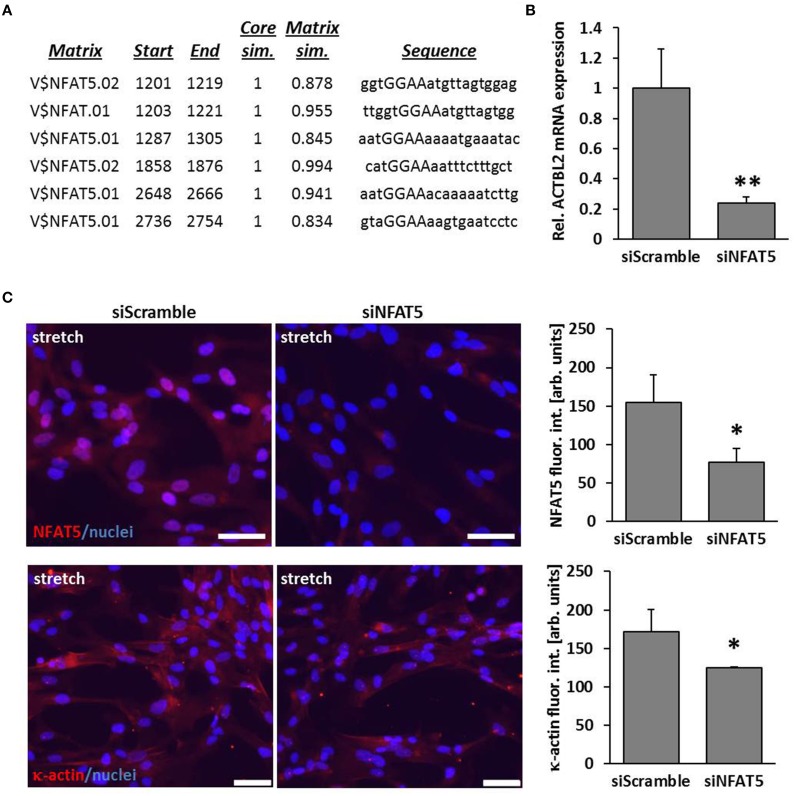
ACTBL2 is a transcriptional target of NFAT5. In silico promoter analysis of the human ACTBL2 promoter revealed six putative NFAT5 binding sites (A). The first 3203 bp of the promoter sequence upstream of the transcription start site were analyzed. The maximum core similarity (Core sim.) of 1.0 is only reached when the highest conserved bases of a matrix are exactly matched by the sequence (cf. capitals in the sequence). A good match to the matrix has a similarity of >0.80 (Matrix sim.). Quantitative PCR (qPCR) of stretch-stimulated HUASMCs treated with NFAT5-specific siRNA (siNFAT5) showed a significant decrease in ACTBL2 mRNA expression compared to stretch-stimulated control siRNA(siScramble)-transfected cells (B, **p < 0.01 vs. control siRNA, n = 3 scale bar: 20 μm). SiRNA-mediated knockdown of NFAT5 (C, *p < 0.05 vs. siScramble) decreased κ-actin (C, *p < 0.05 vs. siScramble) in stretch-stimulated VSMCs as evidenced by immunofluorescence analyses (scale bar: 100 μm).